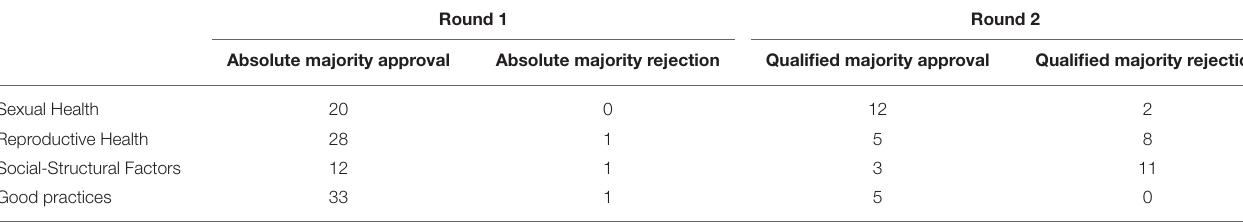
TABLE 3 | Number of indicators, approved or rejected, by group decision rules and round.